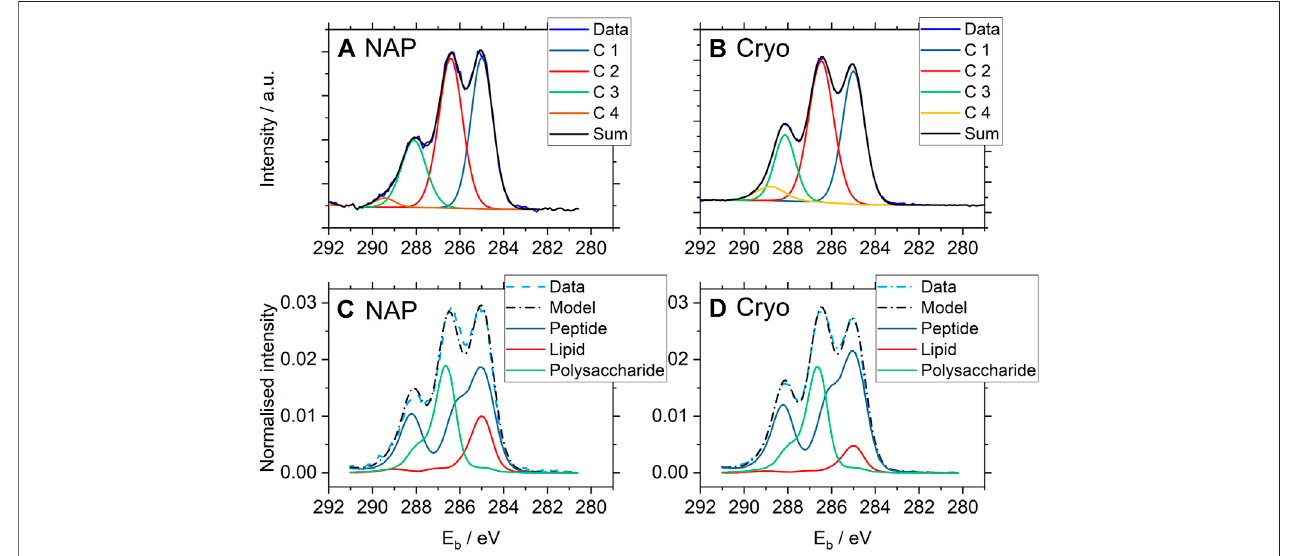
FIGURE4| OneselectedrepresentativehighresolutionC1sspectrumfromeachsetoftheNAP-andcryo-XPspectraof P. fl uorescens acquiredunderNAP (A,C) and cryo (B, D) conditions. The binding energy scales were corrected for surface charging (i.e., the charging potential as de fi ned in ISO 18115 – 1, term 4.103) with respect to the C1s component peak of aliphatic carbon at 285.0 eV, in accordance with ISO 19318:2004. The two upper spectra (A, B) were analyzed by peak fi tting using CasaXPSwithequal fi ttingstrategy(for fi ttingparameters andresultssee Supplementary TablesS2 – S4 ).C1representsaliphatic carbonat bindingenergy 285.0 eV,C2carbon inC-O or C-Nbonds at 286.4 eV,C3carbon in peptide bondsat 288.1 eVand C4carbon incarboxylgroups at 289.1 eV.Thetwolower ones (C, D) show the results of spectral analysis using the Umeå method predicting the amount of substance related to the different molecular classes constituting the bacterial cell-envelope within a surface layer characterized by the information depth of the XPS method.